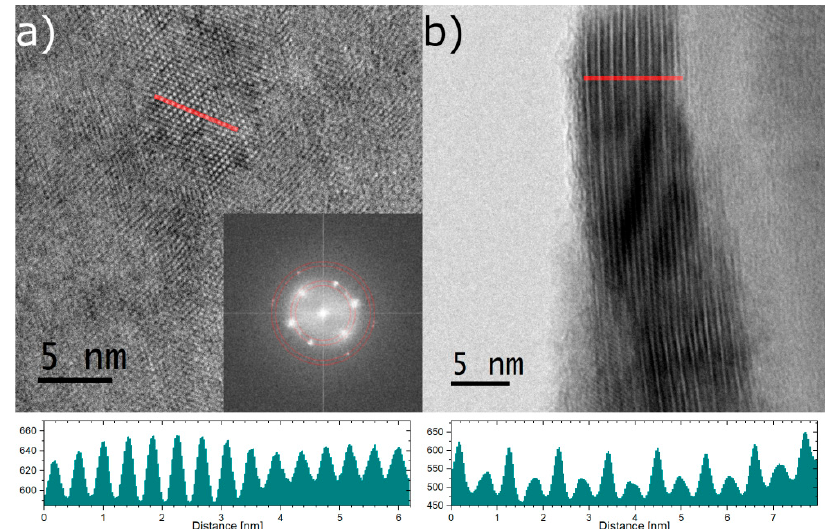
Figure 2. The figure presents transmission electron microscopy high-resolution images of the studied sample. ( a ) shows image perpendicular to the obtained layers. The crystalline character can be clearly visible. The inset shows Fourier Transform with marked by red circles interplanar distances corresponding to the Bi 2 Te 3 structure. ( b ) shows area of the sample where the coating was bent showing the correct arrangement of the layers. Below line profiles of the regions marked by red lines are presented. One can easily notice the periodic structure with interplanar distances belonging to the Bi 2 Te 3 structure.